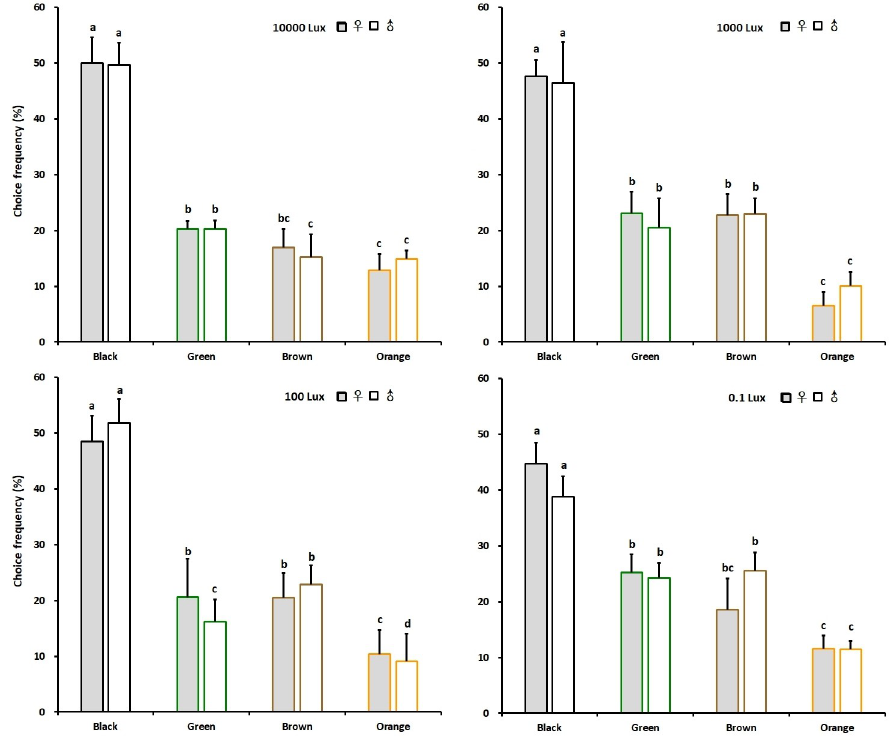
Fig 3. Colour choices in chive gnat Bradysia odoriphaga adults of different colour hues under four different intensity of white illumination. Different letters refer to significant differences according to One-way ANOVA with P <